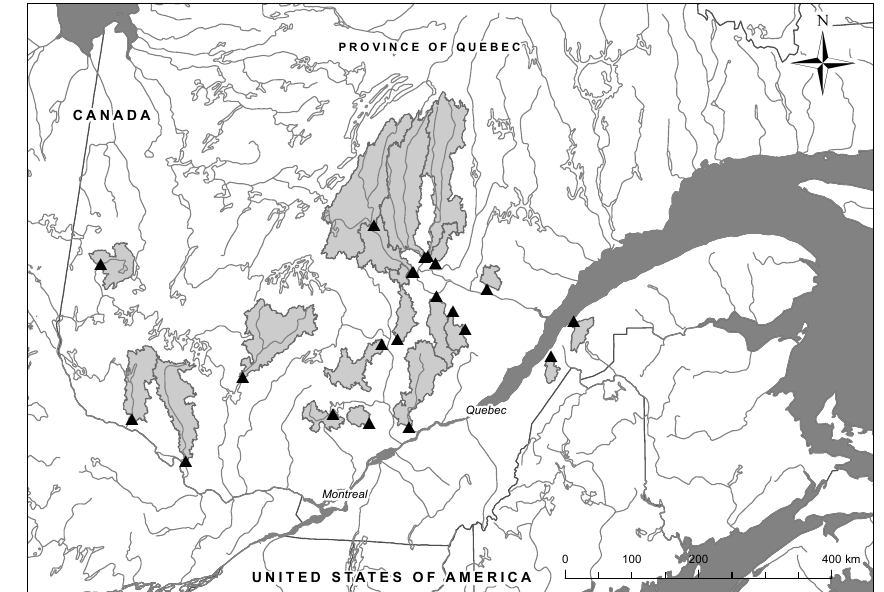
Figure 1. Spatial distribution of the